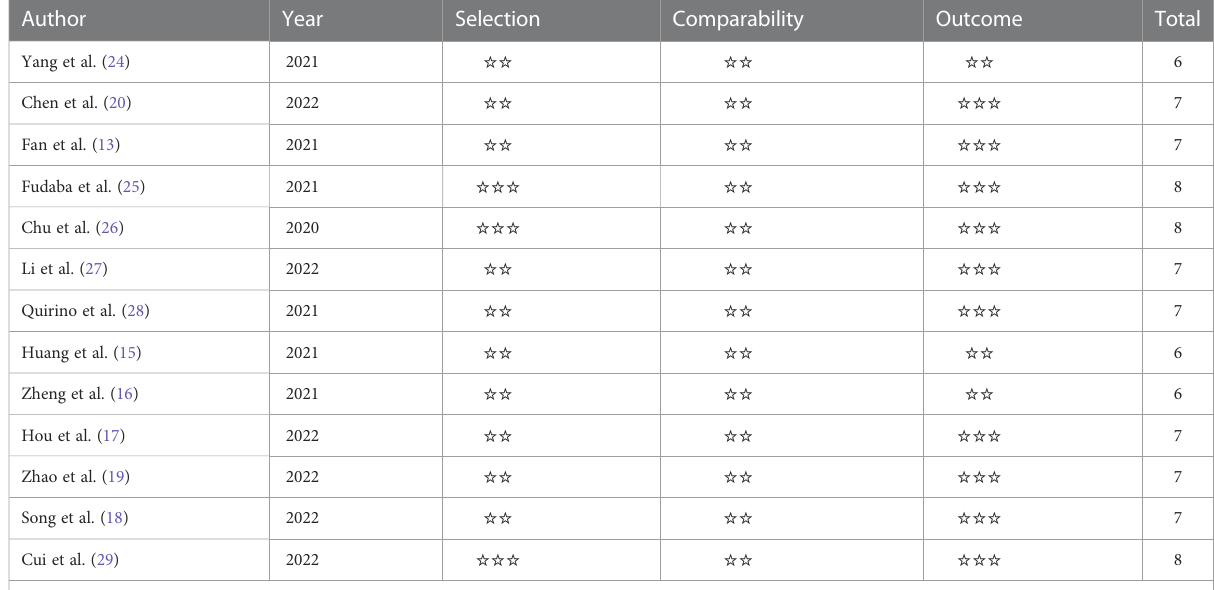
TABLE 2 Quality assessment of all studies included in the meta-analysis with Newcastle-Ottawa Scale.